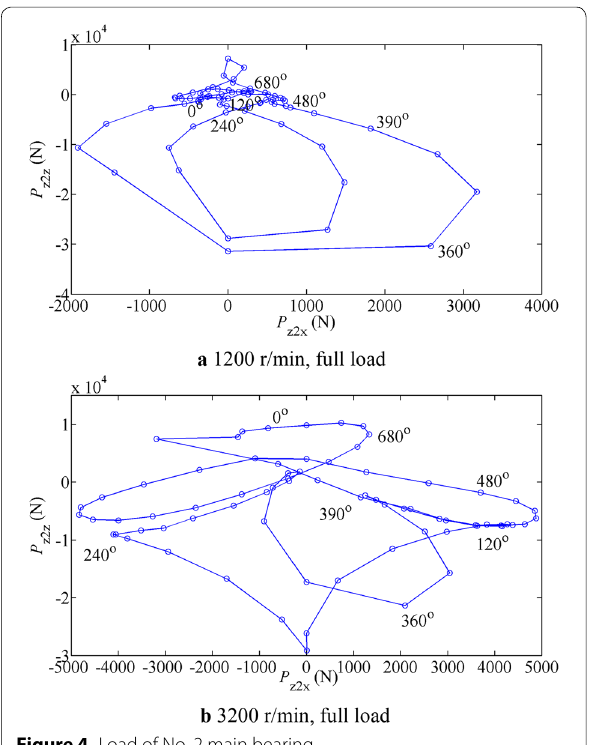
Figure 4 Load of No. 2 main